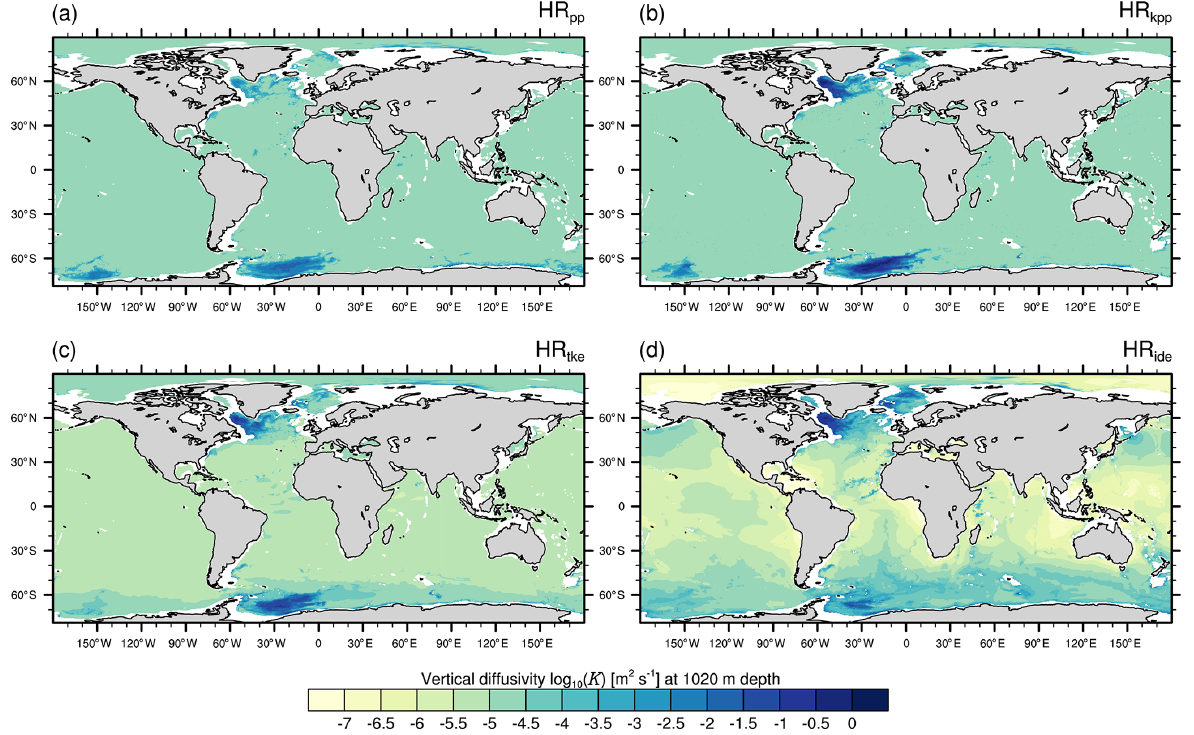
Figure 1. Time-averaged vertical diffusivity log 10 (K) (m 2 s − 1 ) at a depth of 1020m in the MPI-ESM1.2-HR simulations for (a) HR pp , (b) HR kpp , (c) HR tke , and (d) HR ide